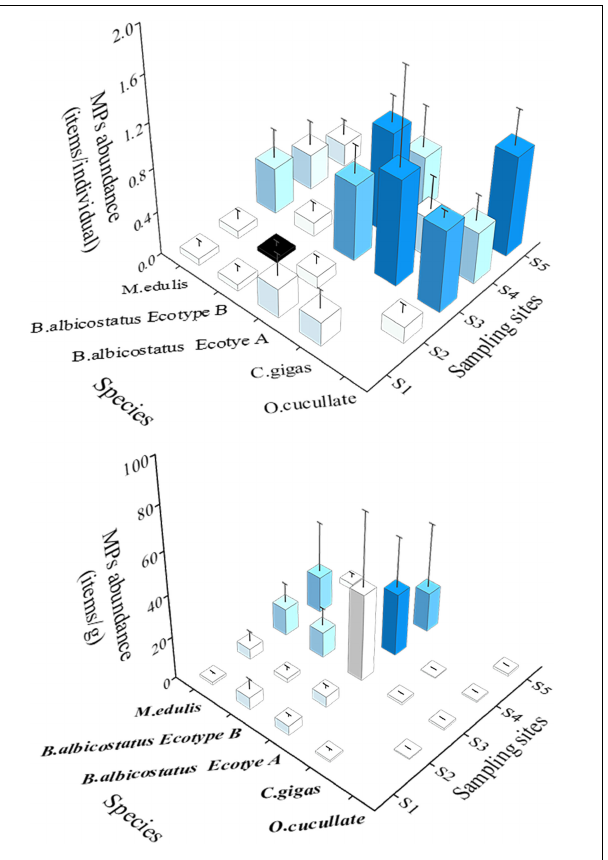
FIGURE 3 | Abundance of MPs (mean ± SD) in four species of barnacles and wild bivalves from different sites in the Yellow